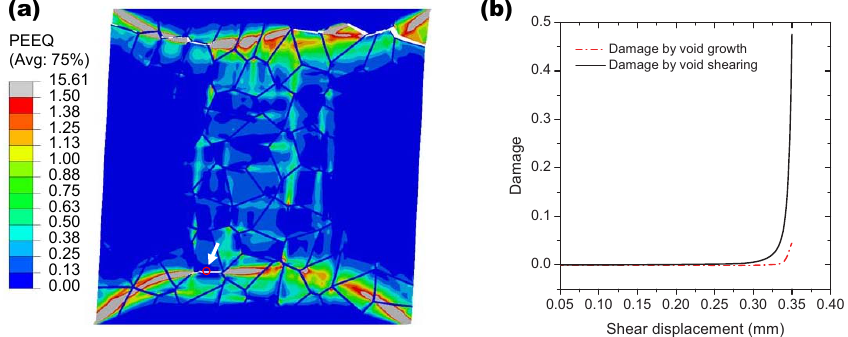
Figure 7. ( a ) the distribution of the equivalent plastic stain (PEEQ) within the grains under the shear loading and ( b ) the corresponding damage evolution of one Gaussian point located in the red circle for both void growth and void shearing.